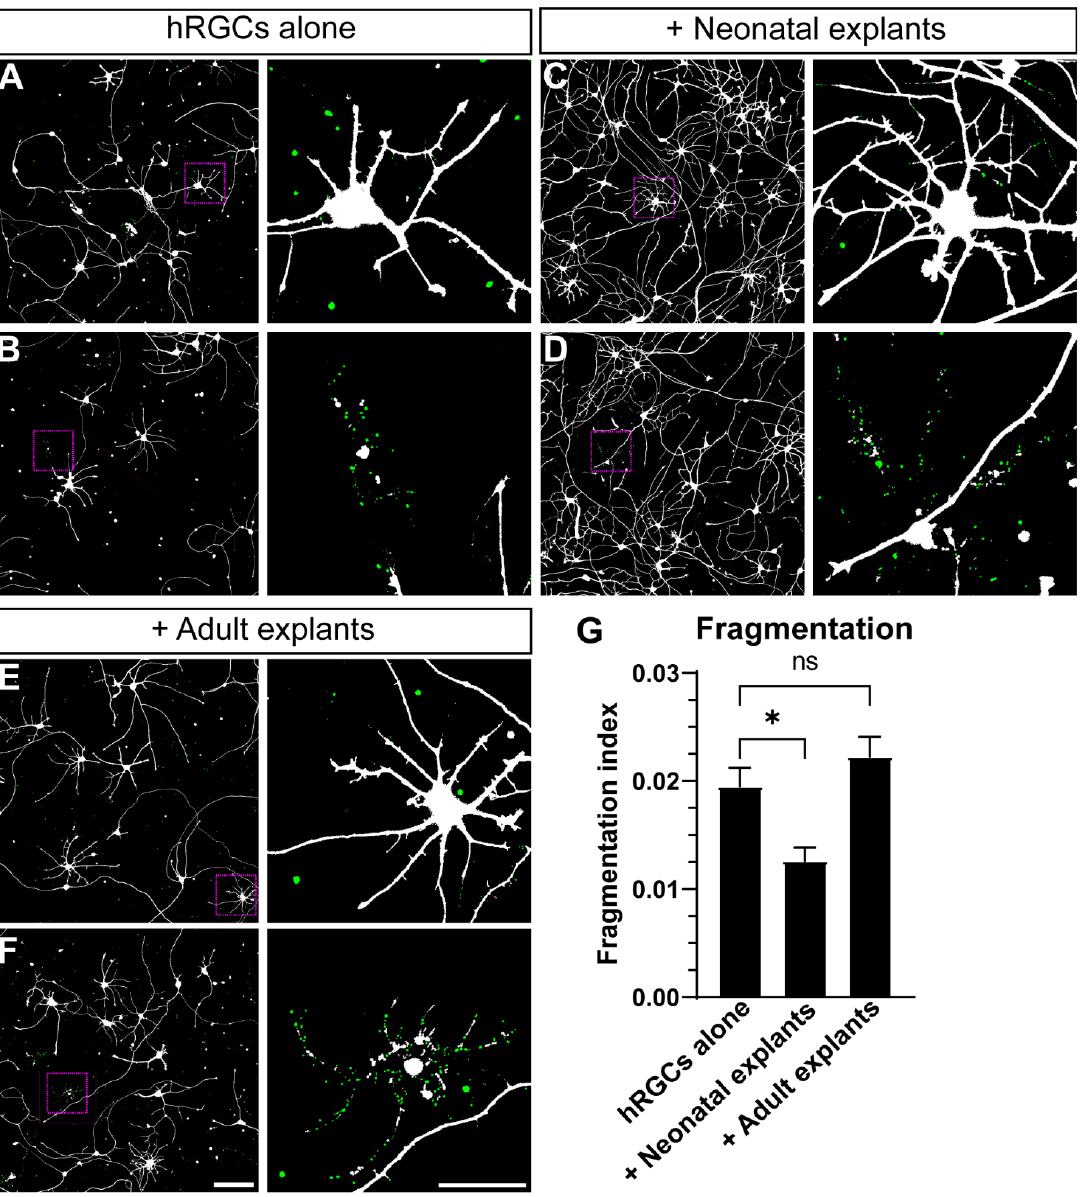
Figure 3. Neonatal explants protect hRGC from fragmentation. ( A – F ) Representative images of 6 DIV hRGCs cultured alone ( A , B ), with neonatal explants ( C , D ), and adult explants ( E , F ). For each condition, right panels represent magnified views of the dashed magenta boxes in the left panels. hRGCs fragments have been digitally colorized in green for visualization. ( G ) A quantification of fragmentation reveals lower levels of fragmentation when hRGCs are cocultured with neonatal ex- plants compared to hRGCs cultured alone ( p = 0.0310). hRGCs alone: N = 4 coverslips, n = 4 2.9 × 2.9 mm images, +Neonatal explants: N = 6, n = 3 – 5, +Adult explants: N = 7, n = 3.-5. Scale bars: F = 150 μm, F zoom = 50 μm. Data are shown as mean ± SEM, * indicates p < 0.05, ns = no significance. Statistical significance was tested using an ordinary one- way ANOVA, Dunnett’s post hoc test.